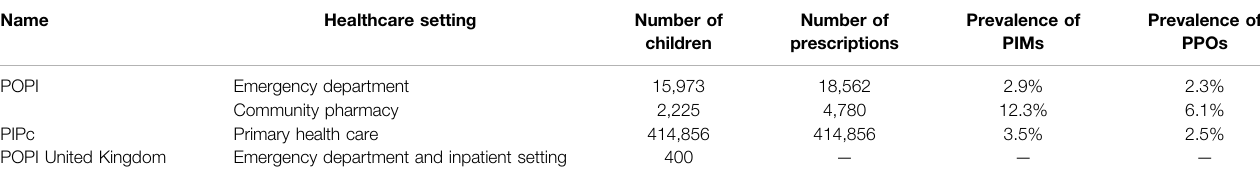
TABLE 3 | Validation studies on children ’ s PIP screening